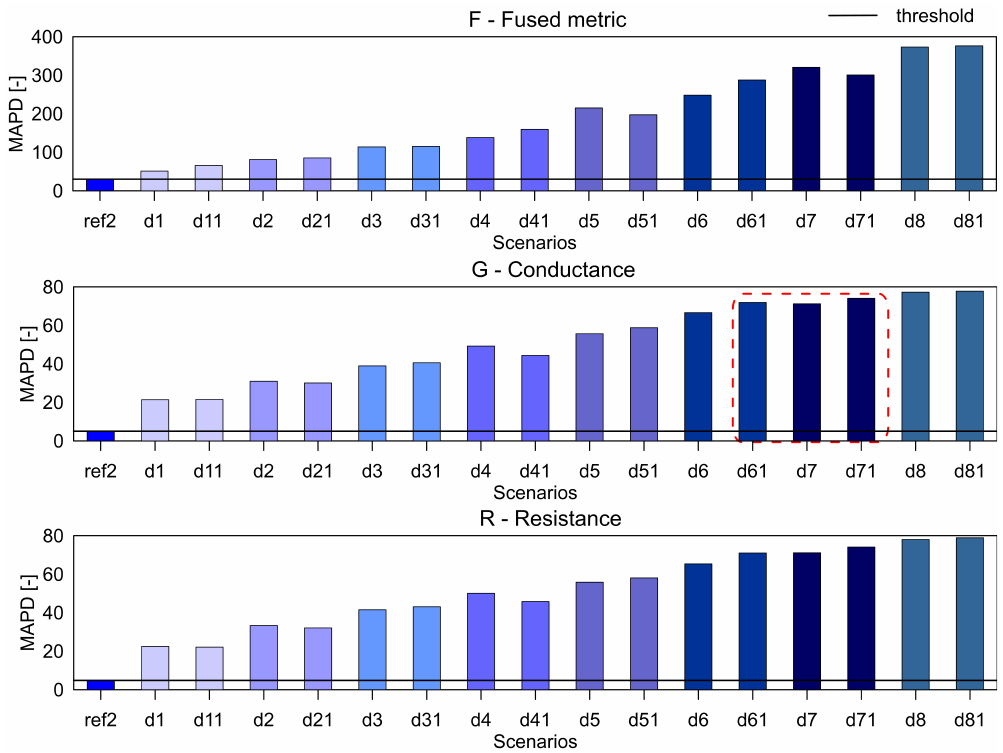
Figure 6. The MAPD index for the variables F, G and R for aluminium